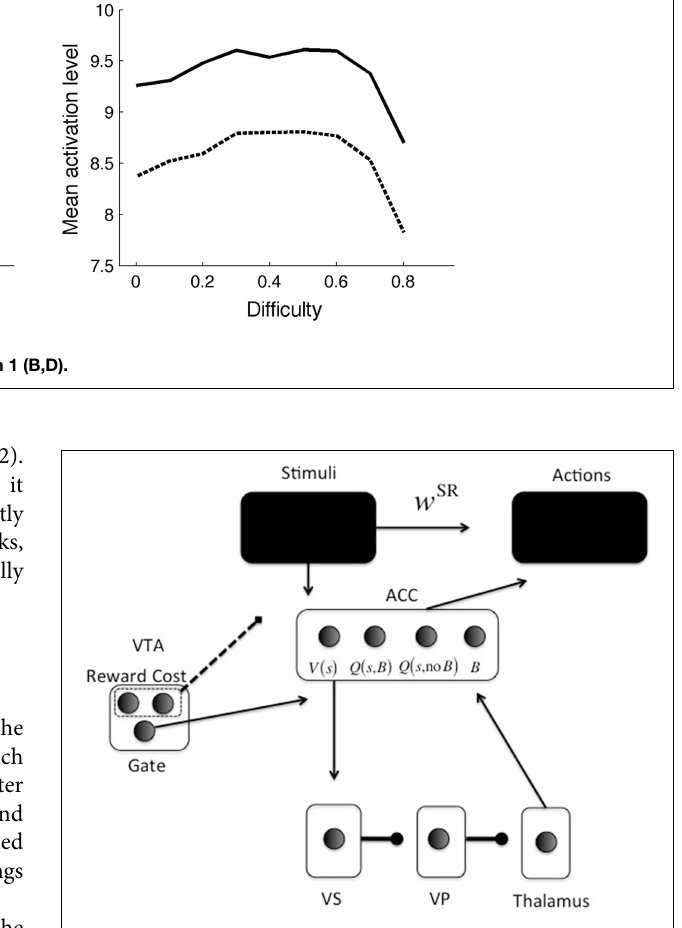
FIGURE 2 | Neurocomputational model. Arrowheads are excitatory; circleheads are inhibitory; the dashed line represents reward and cost feedback (i.e., input for learning). The two black boxes are opened in different simulations. The ACC representation is shown for just one stimulus s : One unit for V ( s ), one for Q ( s , Boost), one for Q ( s , No Boost), and one for boosting the action layer ( B ).